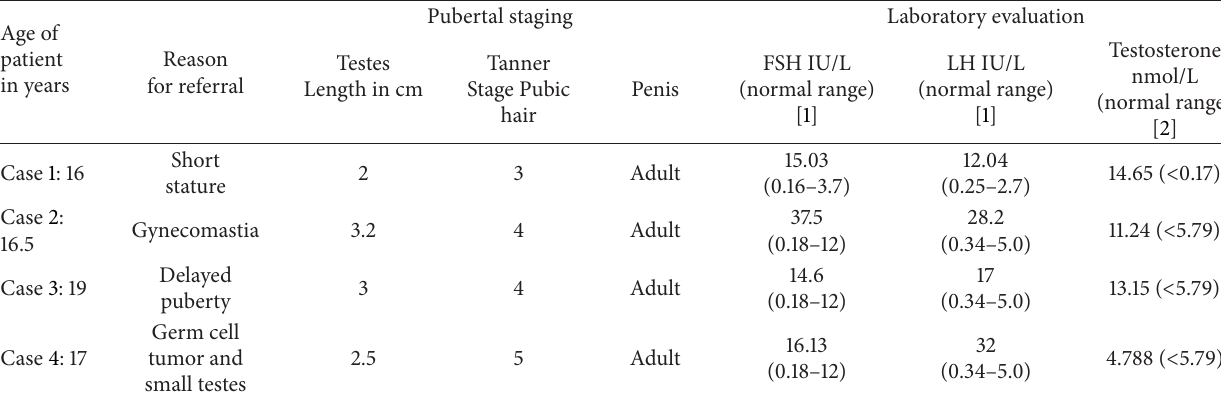
Table 1: Patient